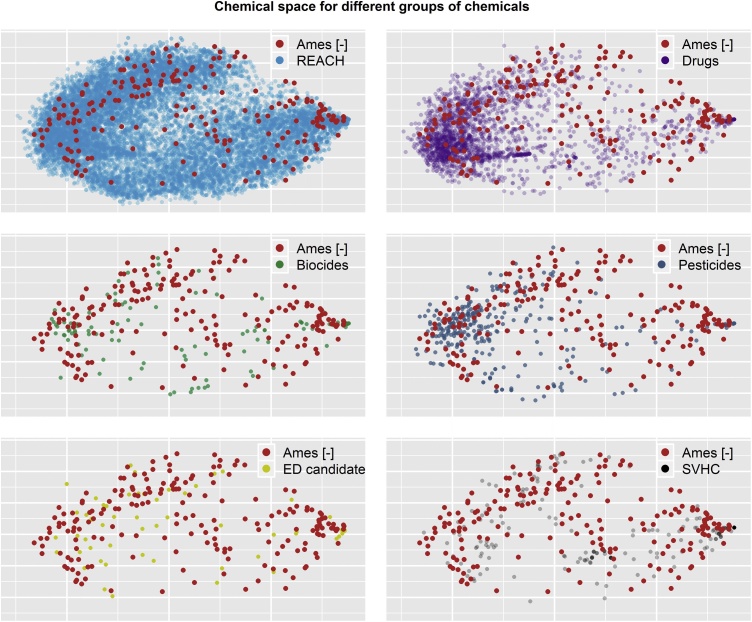
Chemical space of the Ames-negative substances for different groups of chemicals. Chemical space of substances found in the lists of REACH registered substances, drugs, pesticides, biocides, substances of very high concern (SVHC), and endocrine disruptor candidates. The superposition of Ames-negative substances with each of the groups is shown (i.e., red dots). Axes and positions of the substances correspond to the first two principal components of the similarity matrix of the substances built using the RDKit [28] atomic pairs fingerprints. A total of 18904 substances are shown in the chemical space. See caption of Fig. 5 for more information on the sources of the data.